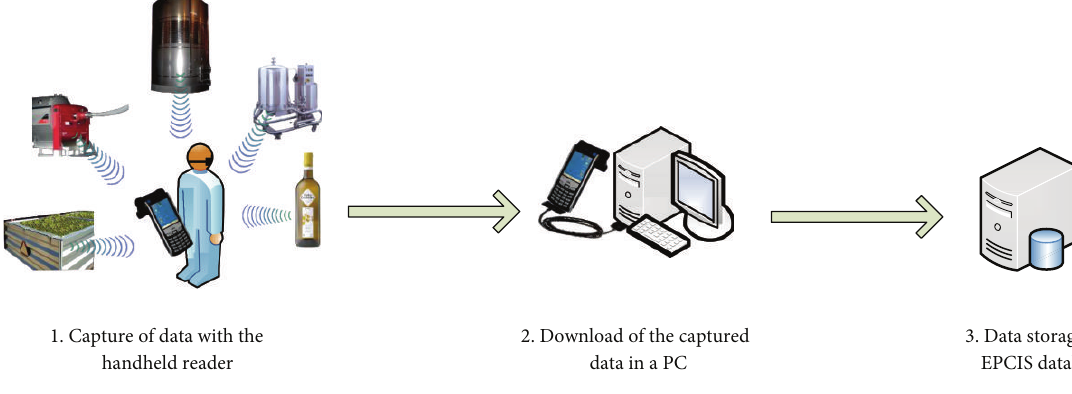
Figure 1: Schema of the data capturing process.